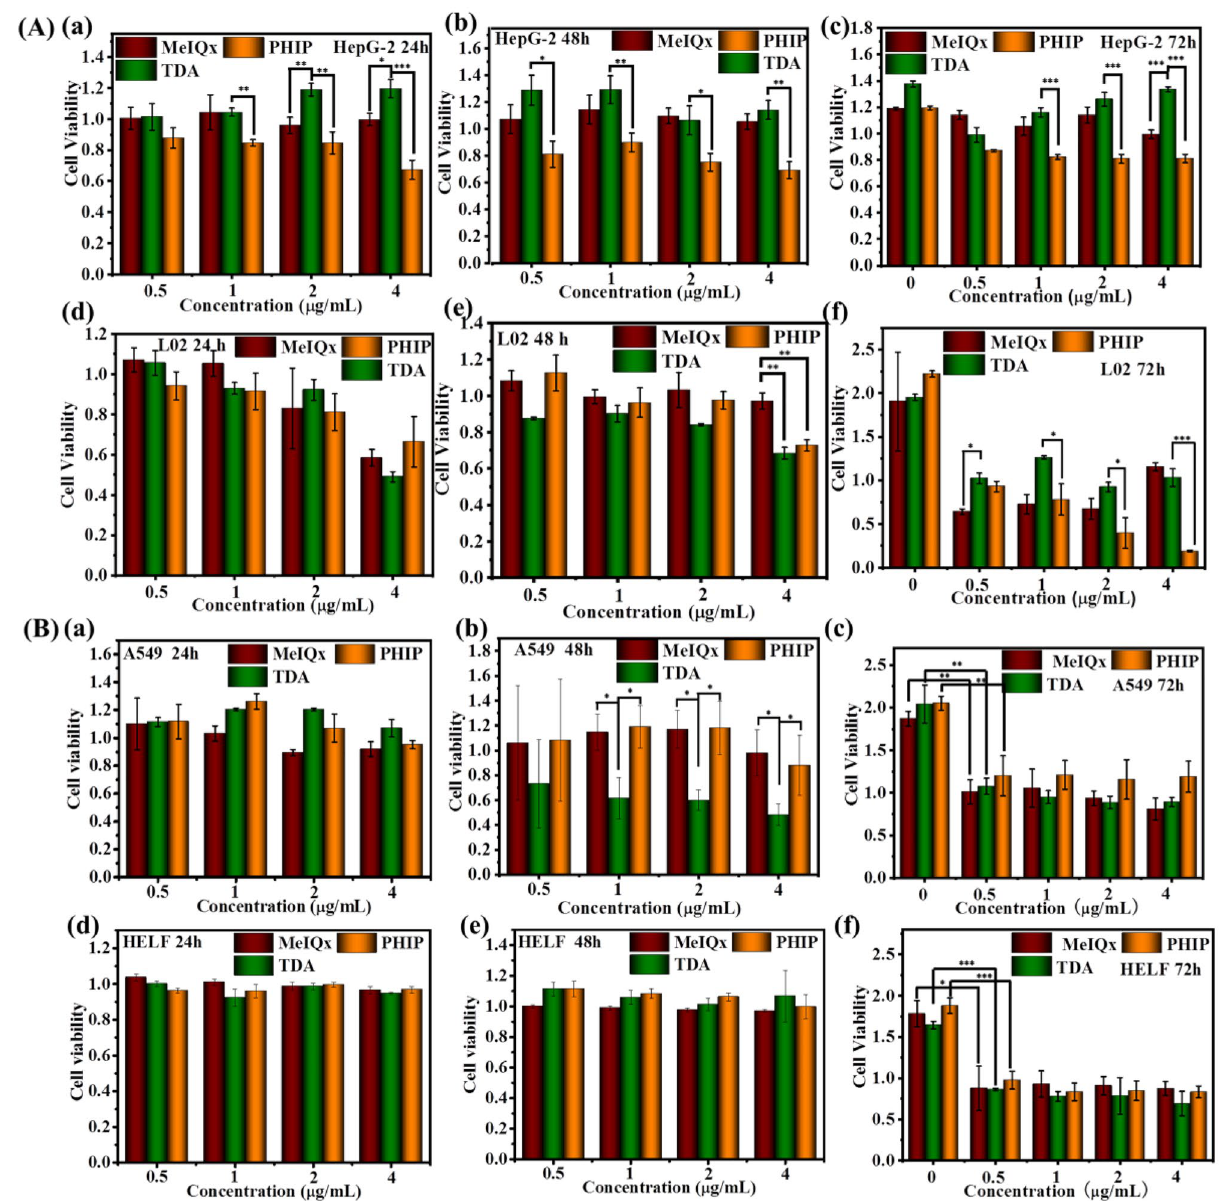
Figure 3. CCK-8 results for ( A ) L02 cells and HepG-2 cells and ( B ) A549 cells and HelF cells incubated with PhIP, MeIQx and TDA under varied concentration from 0.5 to 4 μg/mL, 200 μL, for 24 h, 48 h and 72 h, respectively. The results were given as a mean value of three independent experiments ± SD. The statistical analysis was performed by the one-way analysis of variance-ANOVA followed by Turkey’s post hoc test (* p < 0.05, ** p < 0.01, *** p <